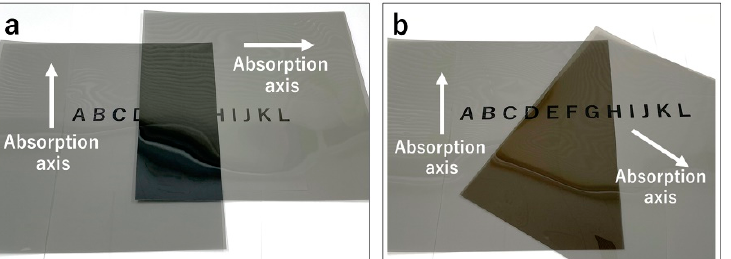
Figure 1. ( a ) The underlying principle of the dichoptic treatment method applied in this study. Light is unable to pass through two polarizing films when their absorption axes overlap so that they are perpendicular to each other. ( b ) If the absorption axis of the polarizing film is not perpendicular, light leakage will occur.